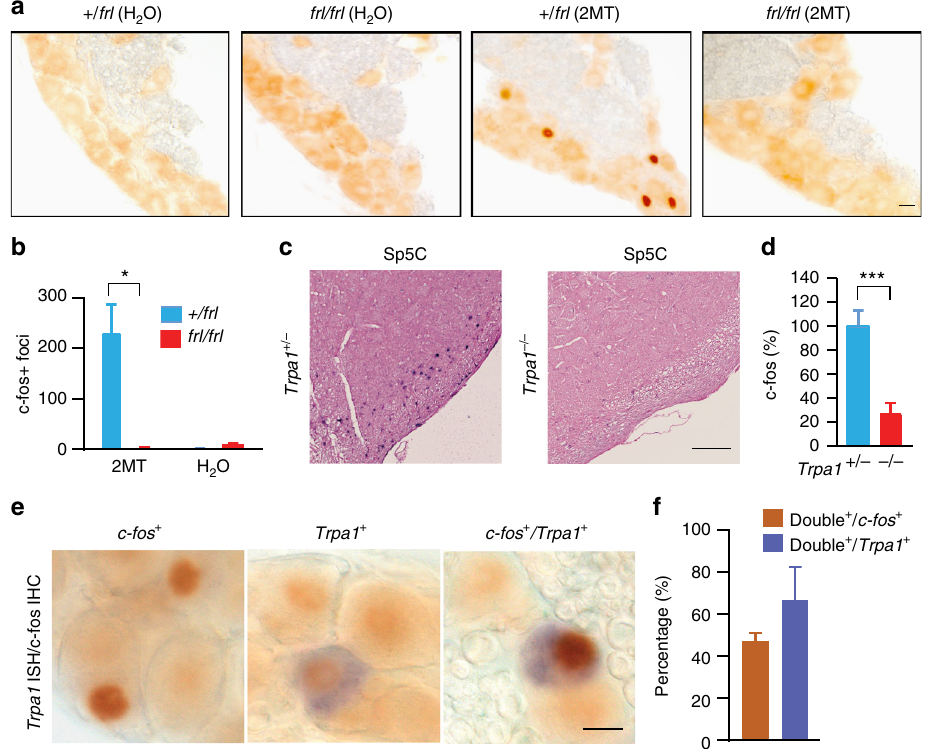
Fig. 6 Trpa1 is essential for 2MT sensing by a subset of TG neurons. a , b Immunohistochemistry (IHC) ( a ) and quantitation ( b ) of c-Fos-expressing TG neurons of Trpa1 + /frl and Trpa1 frl/frl mice after H 2 O or 2MT exposure. Data are presented as mean ± SEM ( n = 4, Student ’ s t -test, * P < 0.05). c , d In situ hybridization (ISH) ( a ) and quantitation ( b ) of c-fos- expressing neurons in the Sp5C of Trpa1 + / − and Trpa1 − / − mice after 2MT exposure. The relative measure (%) of c-fos signals of Trpa1 − / − samples is normalized to those of Trpa1 + / − samples ( d ). Data are presented as mean ± SEM ( n = 4, Student ’ s t - test, *** P < 0.001). e , f Double staining ( e ) and quantitation ( f ) of Trpa1 + , c-Fos + double positive TG neurons of Trpa1 + /frl mice after 2MT exposure. Scale bars are 100 µ m in a and 10 µ m in c and